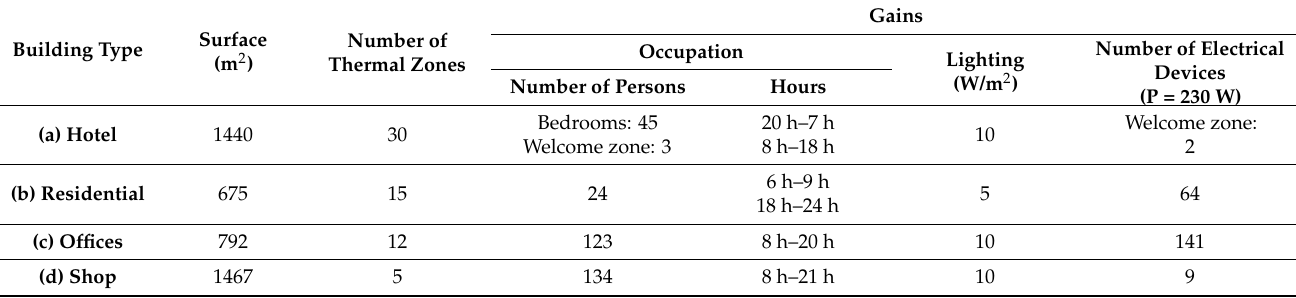
Table 10. Simulation parameters for TRNSYS